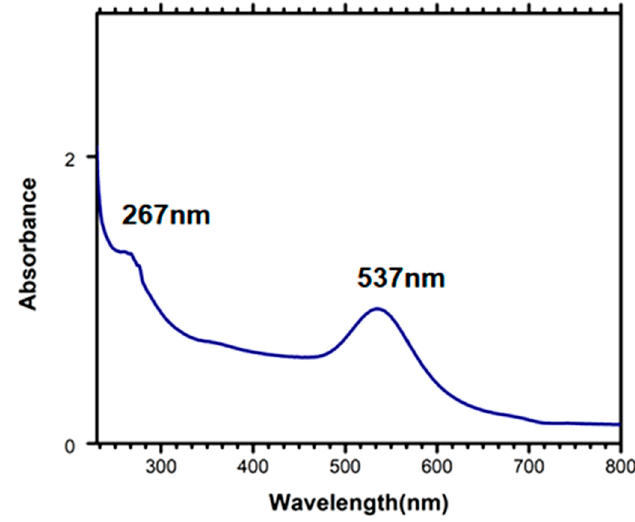
Figure 3. UV-Vis absorption spectra of AuNPs–PDMS with immobilized biorecognition aptamer probe.